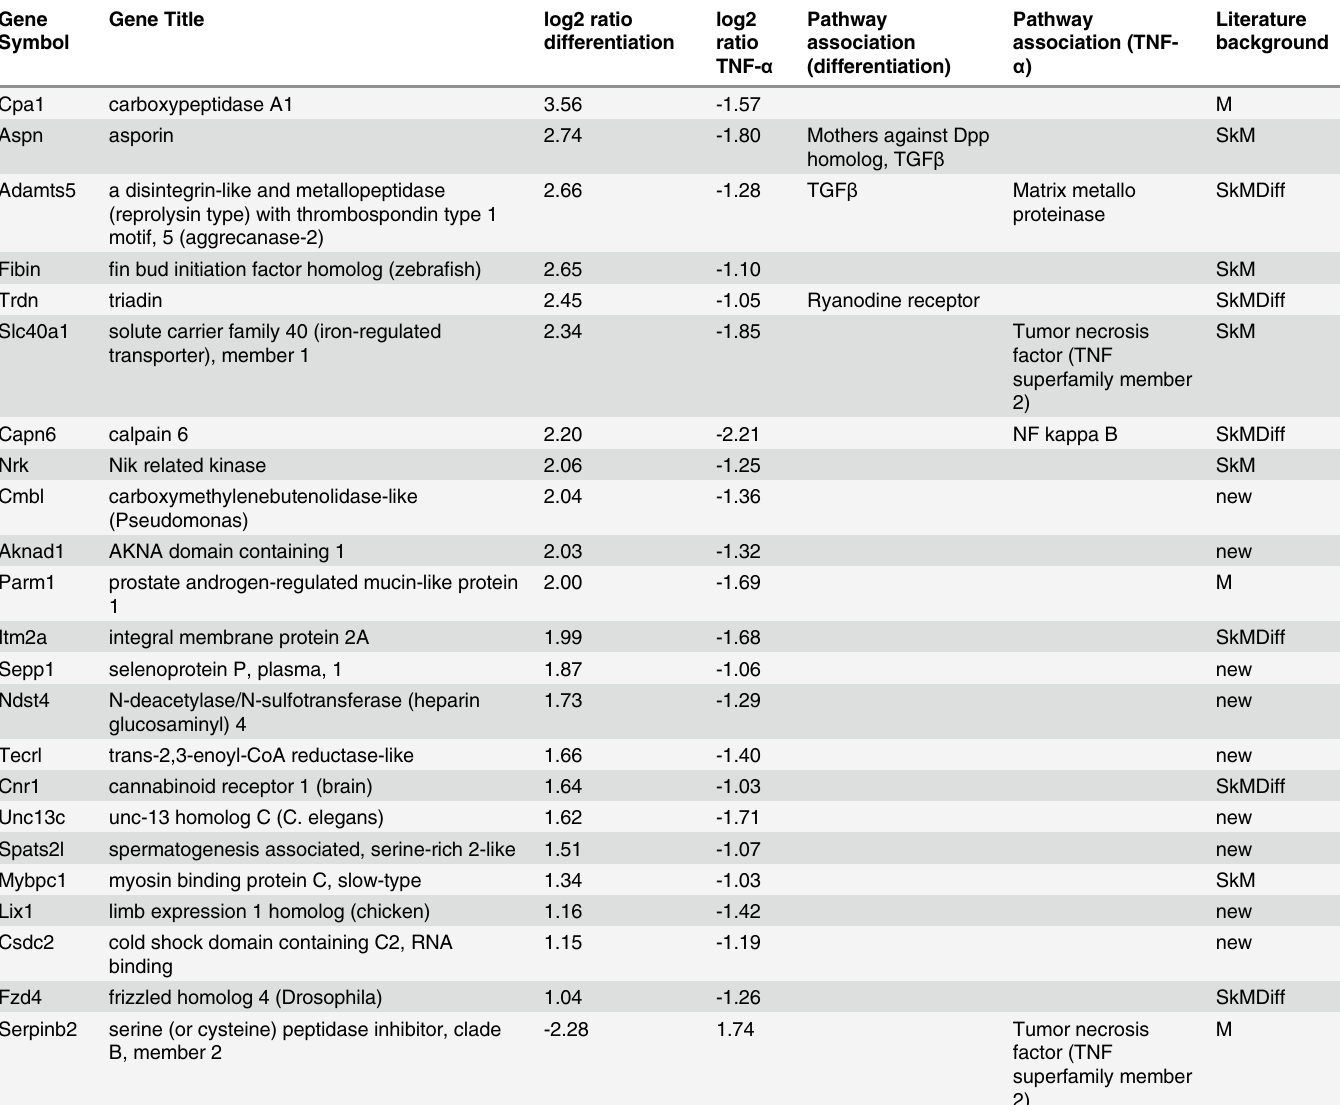
Table 4. TNF- α inversely regulated differentiation genes.